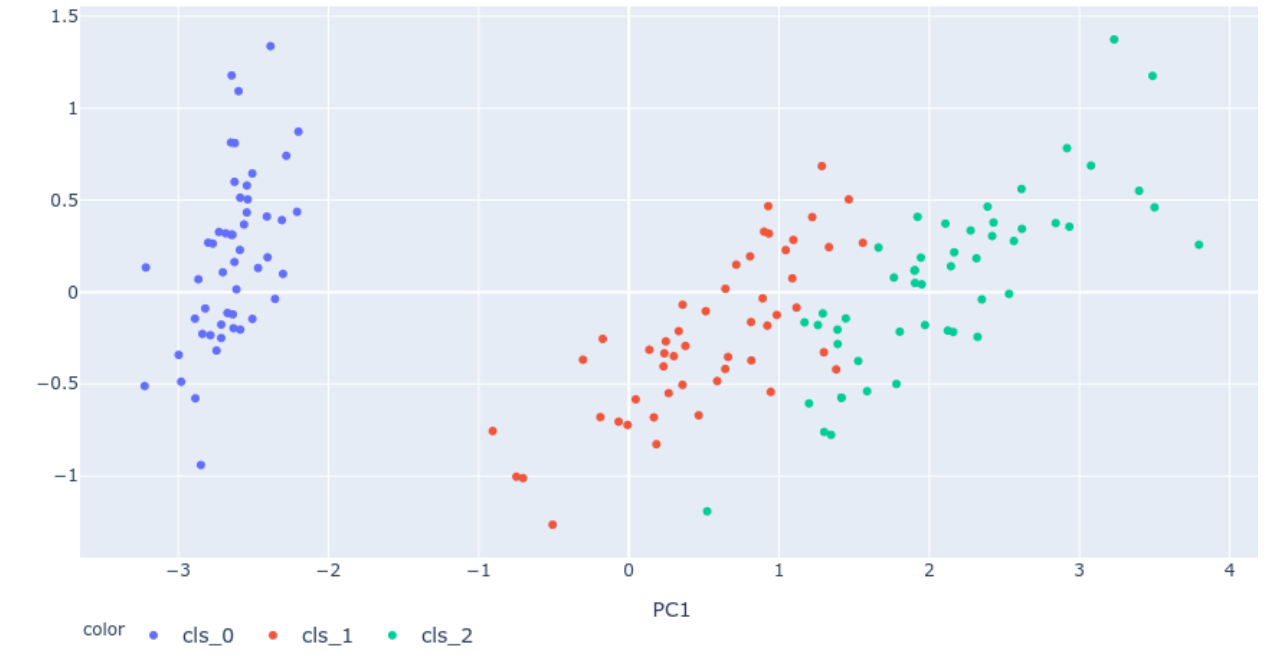
Figure 4. IRIS Principal Components Analysis